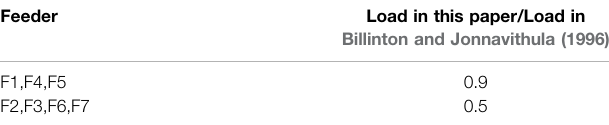
TABLE 3 | Data for bus 4 load ratios. TABLE 4 | Length of Bus 2